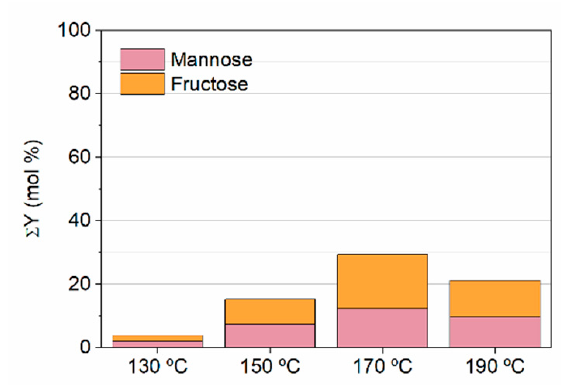
Figure 2. Cumulative product yields achieved in blank reactions performed at different temperatures. Reaction conditions: substrate concentration = 90 mM; reaction time = 6 h.